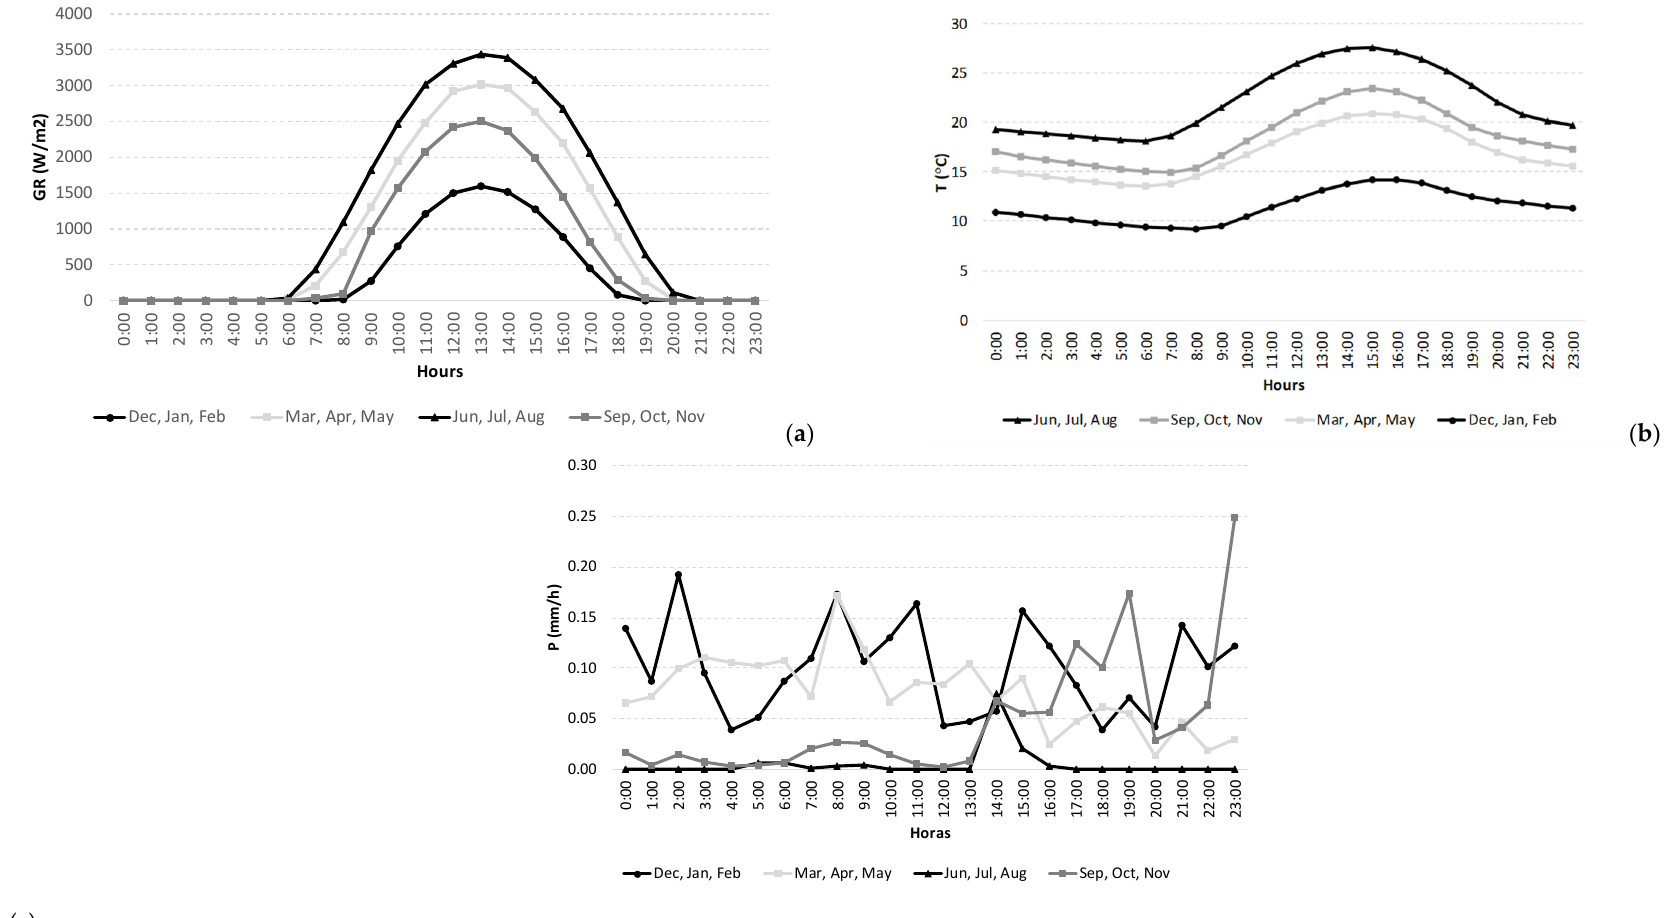
Figure 7. ( a ) Seasonal global radiation; ( b ) seasonal average temperature; ( c ) seasonal precipitation.